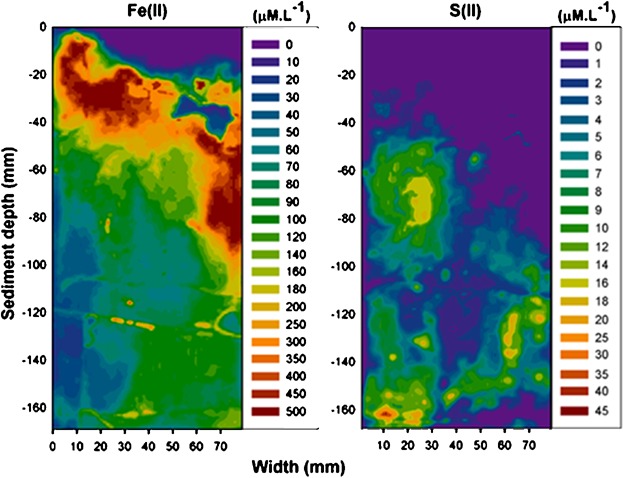
Example of 2-diomensional patterns of Fe(II) and S(II) in sediment (P. Teasdale, personal communication). The Fe(II) is a colorimetric DET measurement and the sulfide is a colorimetric DGT measurement; both measured by computer imaging densitometry at 1-mm resolution. The dark blue zone amongst the high Fe(II) at approximately 40 mm depth and 60 mm from left to right is an artifact in which the gel had broken on contact with a shell. © 2014 by the Association for the Sciences of Limnology and Oceanography, Inc.